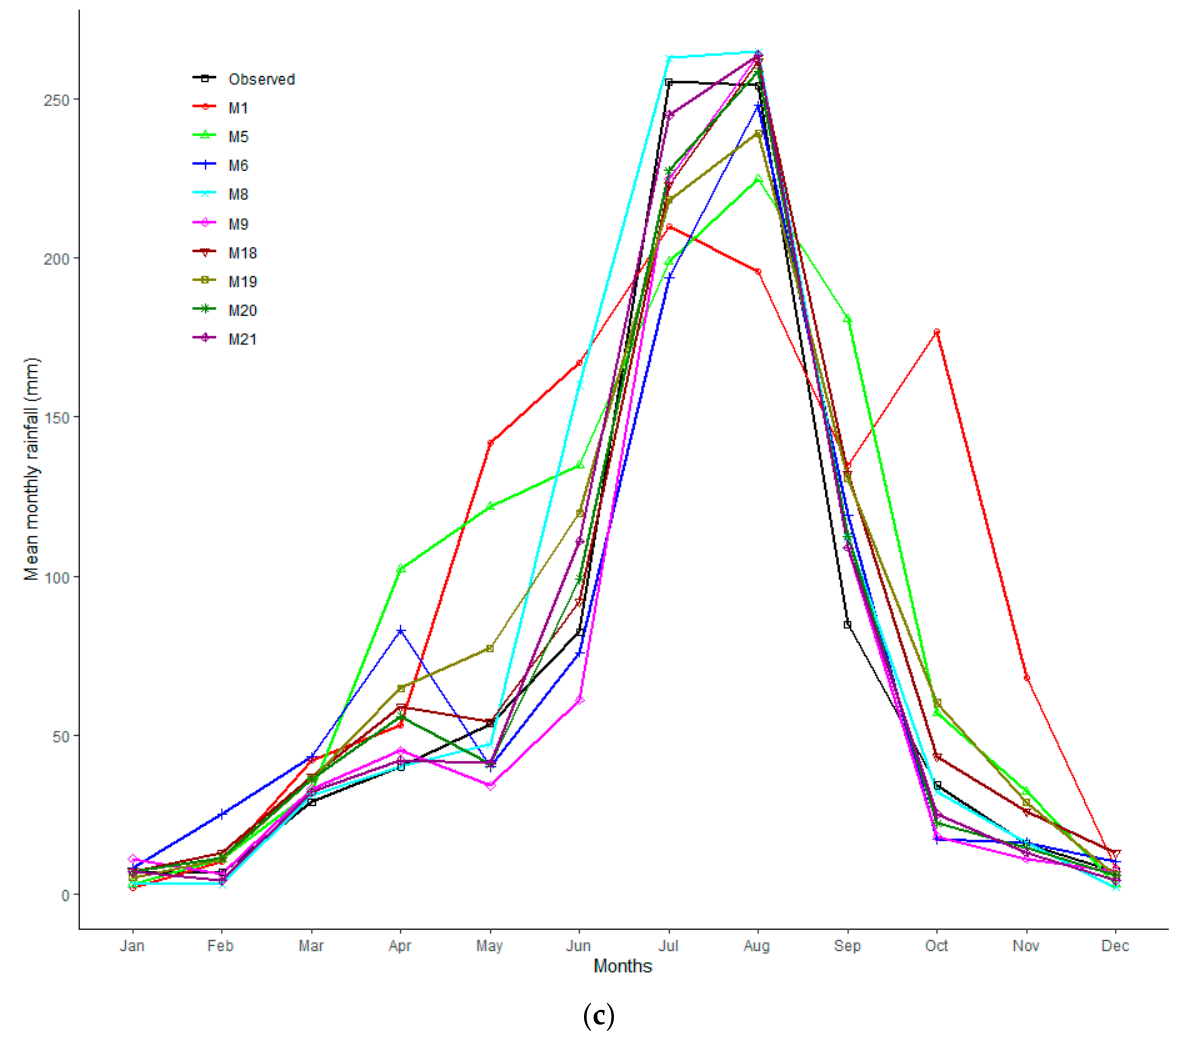
Figure 9. Climate models (including ensembles) comparison result using observed data as a reference over the historical period (1986–2005) ( a ) Bias in mean annual rainfall from all models, ( b ) Bias in annual rainfall in selected models ( c ) Annual rainfall pattern in selected models.